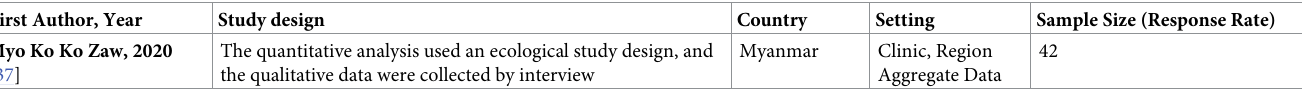
The color of the arrows on the pathway chart indicates three steps in care-seeking: blue for the first visit, red for the second and subsequent visits, and black for active case detection by health staff. The chart shows that someone may need to make a series of visits before they are diagnosed, a possibility that is due partly to leprosy’s susceptibility to misdiagnosis, which can therefore lead to several visits, and possibly referrals to other health services.